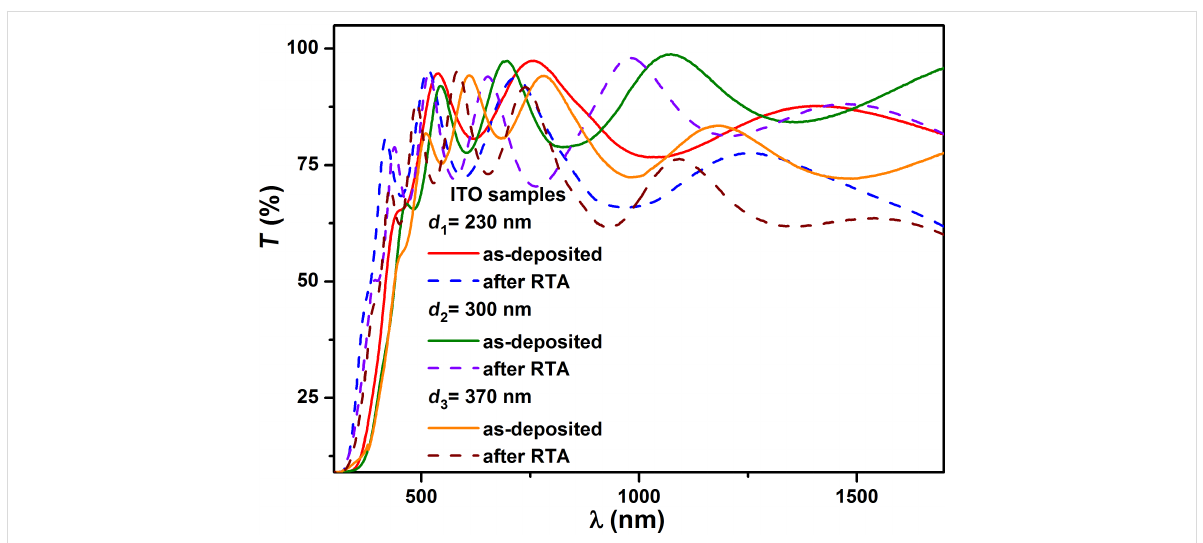
Figure 5: Optical transmission spectra for the as-deposited and RTA-treated ITO samples with interference maxima and minima for film thickness of 230 nm, 300 nm, and 370 nm.